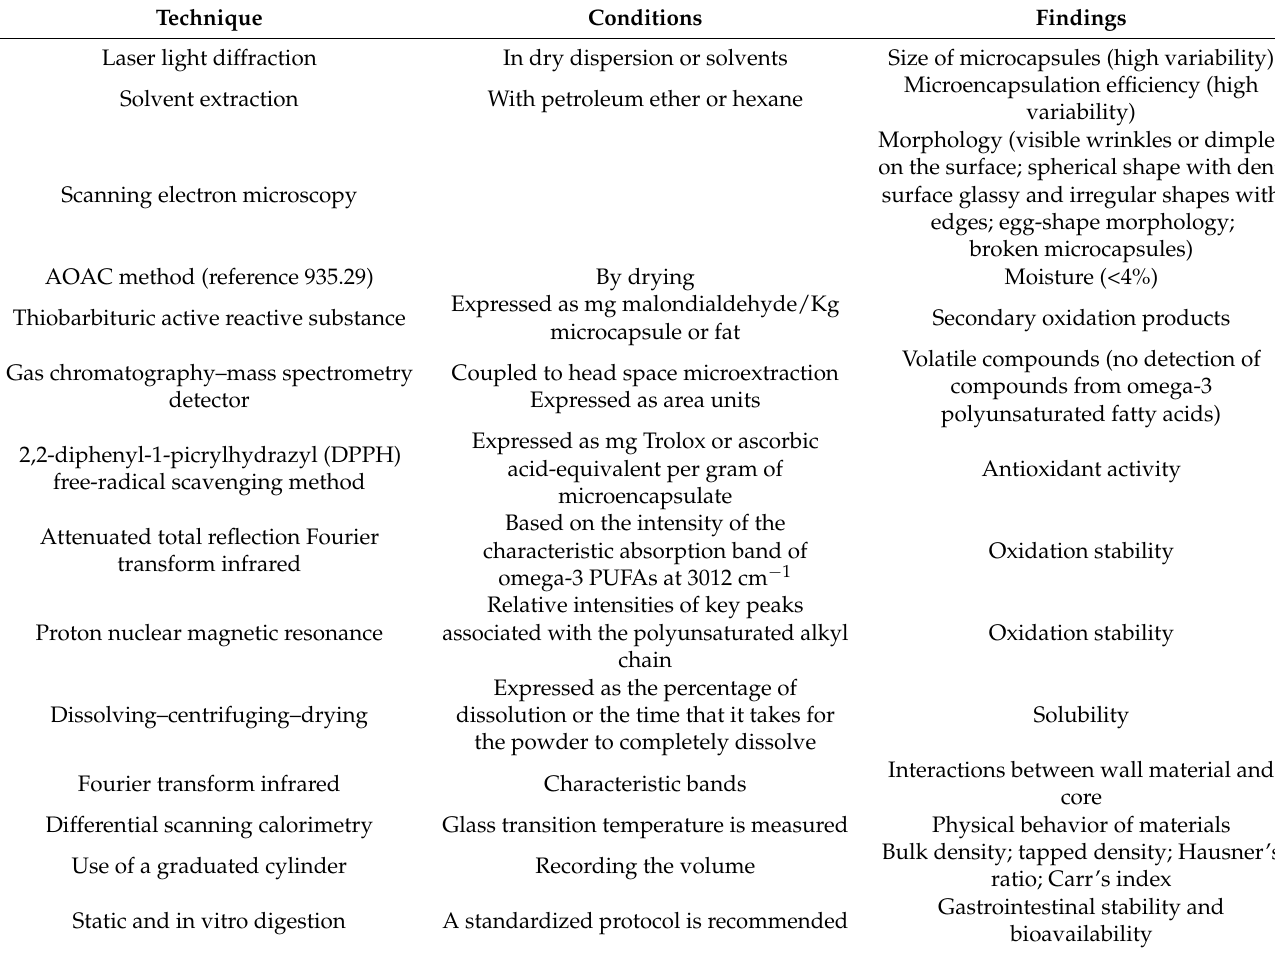
Table 3. Most used techniques for the quality evaluation of fish oil and antioxidant